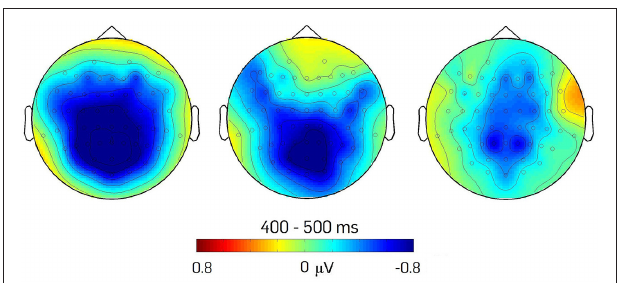
FIGURE 4 | Scalp distribution of the effects of modulation of the N400 component. The topographical maps show: (a) the difference between the verbs in Telic and NonTelic combinations in Neutral contexts (N_CON-NonTelic minus N_CON-Telic); (b) the difference between the verbs in NonTelic combinations in Neutral vs. ad-hoc affordance-inducing context (N_CON-NonTelic minus A_CON-NonTelic); (c) the difference between the